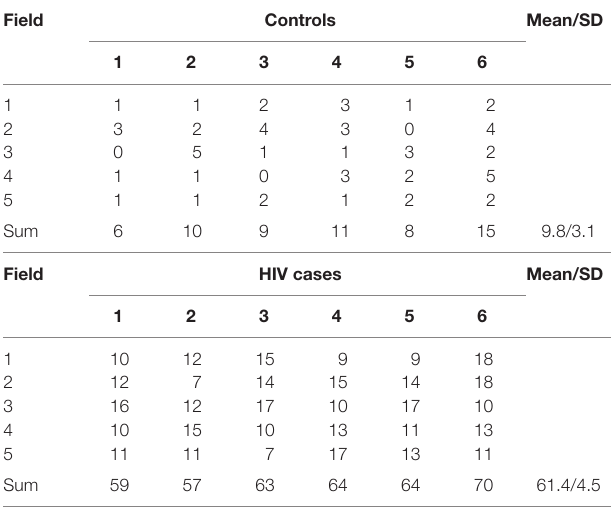
TaBle 2 | Quantitative analysis of plasmacytoid dendritic cells (pDcs).